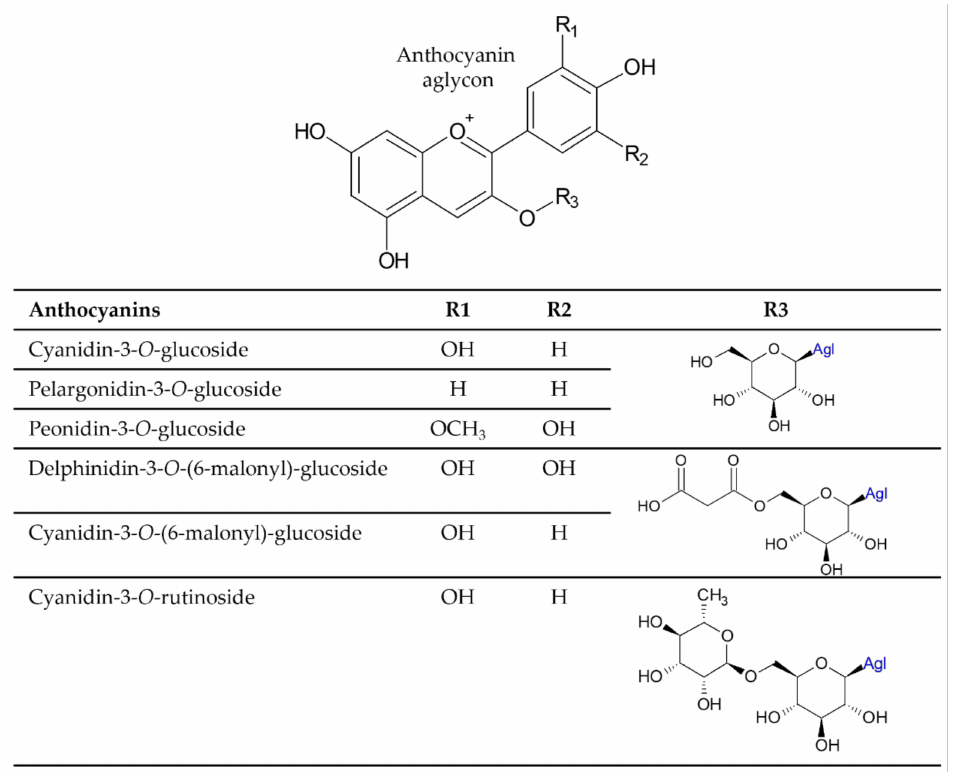
Figure 1. Examples of anthocyanins structures are reported in red chicory. Agl: anthocyanin aglycon. The general goal of this work is to develop a sustainable extraction method for red chicory anthocyanins as a green alternative source of natural dyes. In this framework, we used statistical experimental designs to develop a sustainable extraction protocol for red chicory leaves, followed by the analysis of the extracted anthocyanins and their utilization for textile